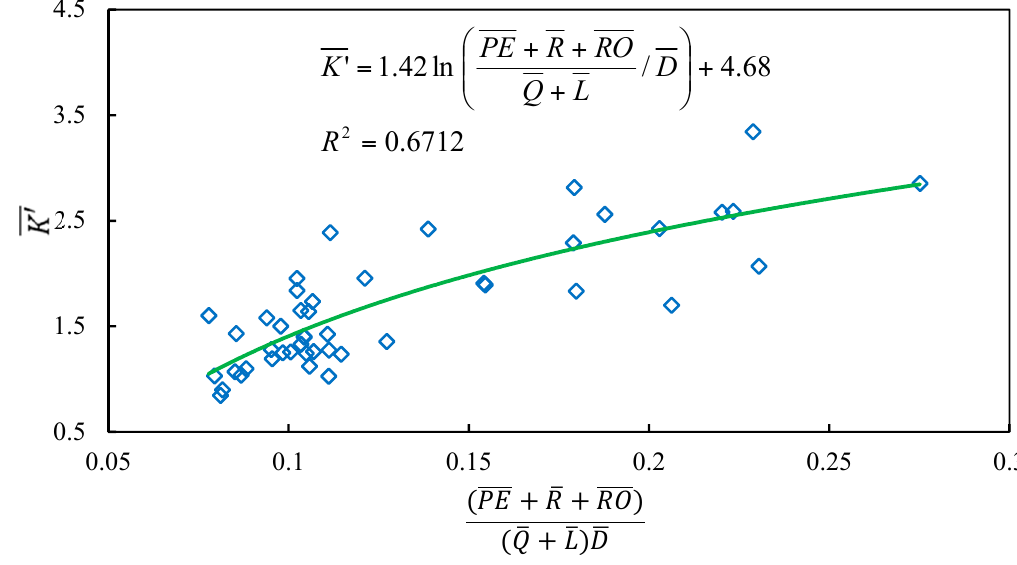
Figure 4. The average annual weighting factor related to average moisture demand, average moisture supply and the average absolute moisture anomaly.